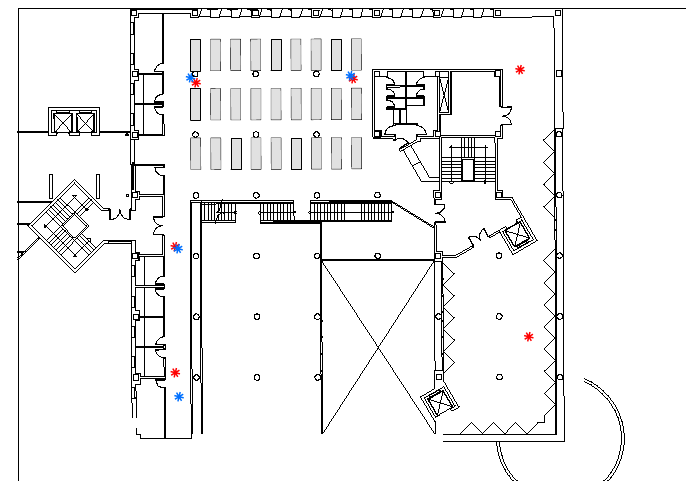
Figure 2. Experimental environment.